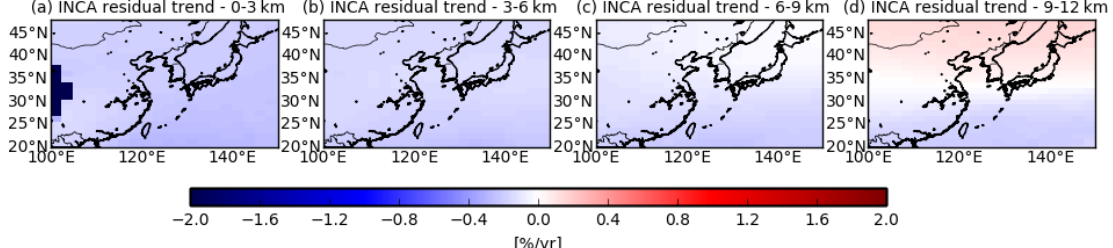
Figure B1. Residual O 3 trend derived from the INCA simulation in which all the emissions, CH 4 , and meteorology are kept constant to their 2007 values. The trend is calculated for the 0–3, 3–6, 6–9, and 9–12km O 3 partial columns.